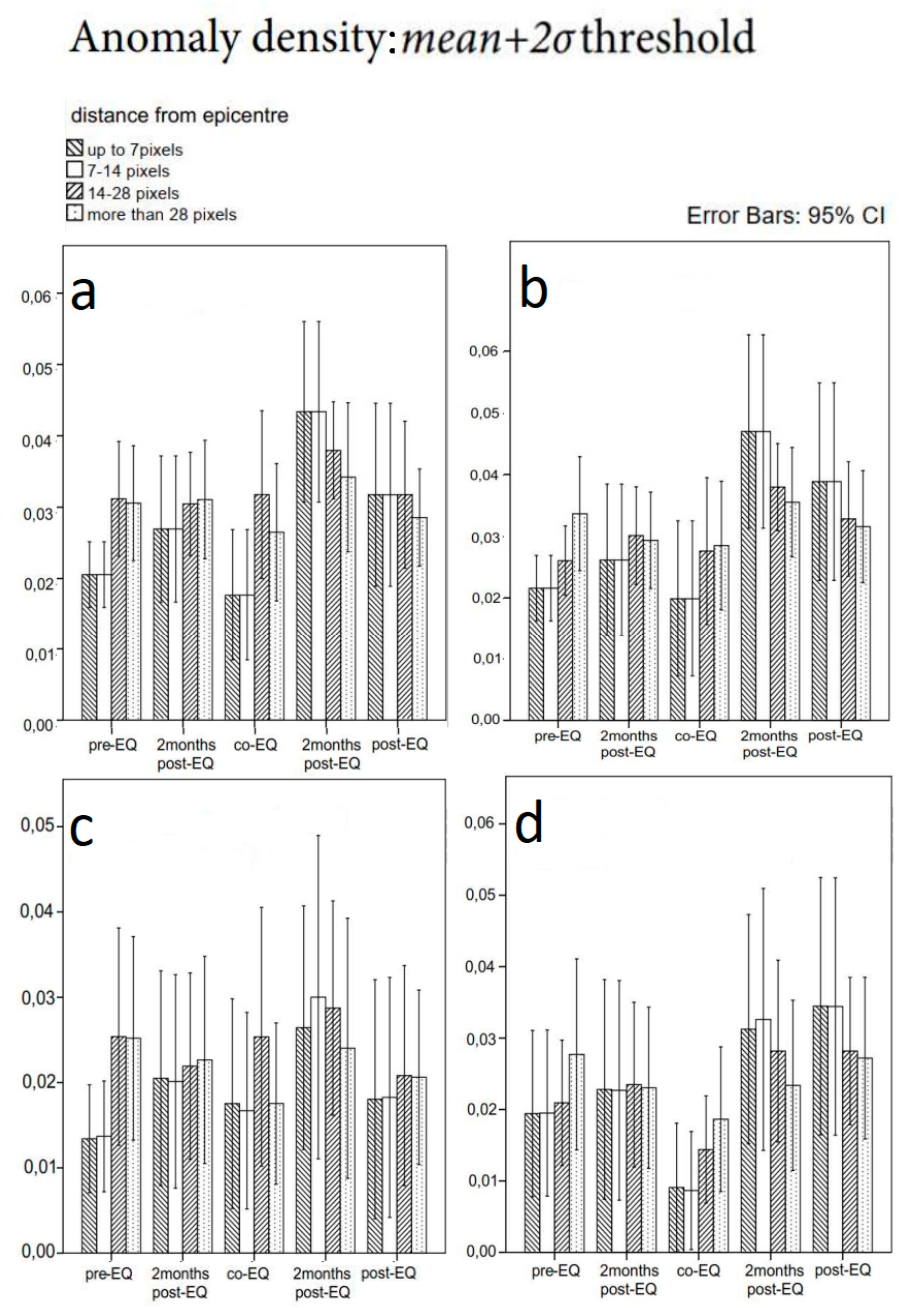
Figure A1. Anomaly density using a µ + 2 σ threshold and 48 h- or adjusted co-seismic period. Results from all earthquake cases grouped per time period, spatial zone and earthquake year. ( a ) Earthquake years, 48-h co-seismic period ( b ) No-Earthquake years, 48-h co-seismic period ( c ) Earthquake years, adjusted co-seismic period ( d ) No-Earthquake years, adjusted co-seismic period.